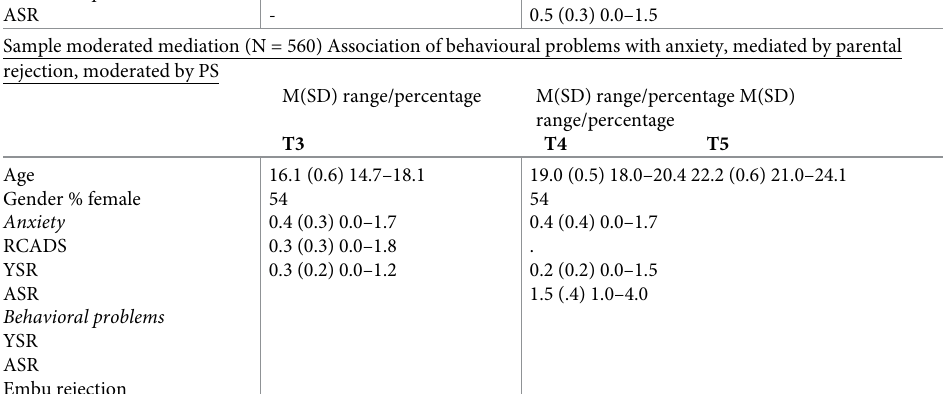
items, Cronbach’s α = .63), social phobia (9 items, Cronbach’s α = .86), generalized anxiety disor- der (6 items, Cronbach’s α = .79), and panic disorder (9 items, Cronbach’s α = .77). At T3, anxiety was also assessed with the anxiety subscale of the Youth Self Report (YSR). The YSR consists of 112 items (scored on a 3-point scale from 0 = not true to 2 = very/often true) on behavioral and emotional problems in the past 6 months ([46]. The mean item score of the DSM-IV anxiety subscale of the YSR (6 items, Cronbach’s α = 0.65) was included only in the moderated mediation analysis of this study to control for anxiety symptoms at T3. For this analysis the YSR was preferred over the RCADS, because of the YSR’s similarity with the outcome measure (the Adults Self Report) used in the moderated mediation analysis. At T5, anxiety was assessed using the adult version of the Adult Self Report (ASR) which consist of 102 items (scored on a 3-point scale from 0 = not true to 2 = very/often true) on behavioral and emotion problems in the past 6 months [46]. The mean item score of the DSM-IV anxiety subscale of the ASR (7 items, Cronbach’s α = .76) was included in the current study.